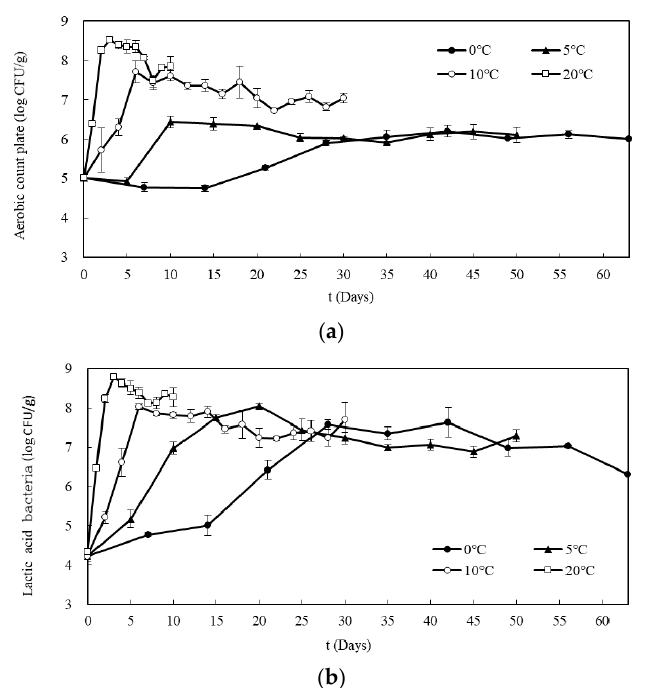
Figure 3. Changes in ( a ) aerobic count plate and ( b ) lactic acid bacteria of Kimchi during fermentation at 0, 5, 10, and 20 °C.